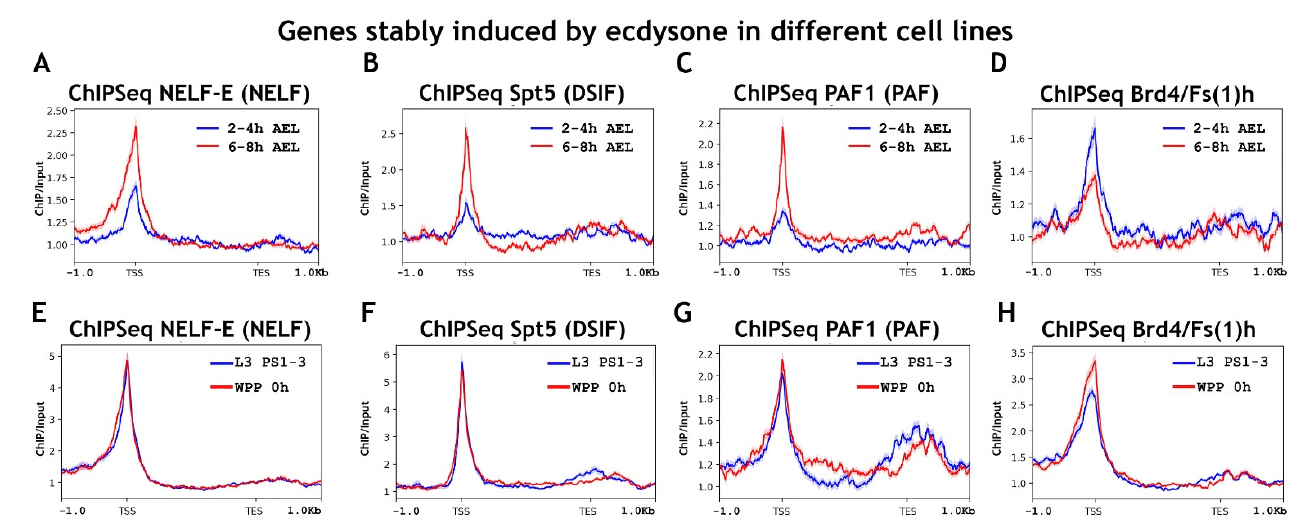
Figure 8. Average binding profiles of NELF-E (NELF), Spt5 (DSIF), PAF1 (PAF), and Brd4/Fs(1)h on genes induced by ecdysone during Drosophila embryogenesis and metamorphosis average distribution of ( A , E ) NELF-E (NELF complex); ( B , F ) Spt5 (DSIF complex); ( C , G ) PAF1 (PAF complex); and ( D , H ) Brd4/Fs(1)h binding across the genes induced by 20-hydroxyecdysone (ecdysone) at various stages of Drosophila development (total 68 genes/236 transcripts). A pool of ecdysone-induced genes was selected using previously published data on the ecdysone response of various Drosophila cell lines [55]. ChIP-Seqs were performed on whole embryos of 2–4 h (blue line at ( A – D )) and 6–8 h (red line at ( A – D ) after eggs laying (AEL); on whole larvae of L3 PS1–3 full gut stage (blue line on ( E – H )), prepupae 0 h after puparium formation (WPP, red line on ( E – H )). Protein binding levels were calculated as an enrichment (ratio of the corresponding ChIP-Seq signal to the input DNA). Average profiles were generated using the metagene mode (introns were ignored and gene bodies were scaled to 2 kb) and calculated as the mean of the protein binding signal. The standard error appears on the graphs as a lighter area around the main line of the profiles. Abbreviations: L3 PS1-3: full gut stage of larva L3; WPP 0 h: white prepupa; TSS: transcription start site; TES: transcription end site.